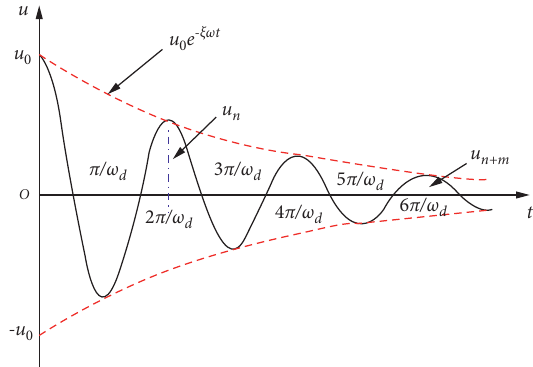
Figure 3: Time-history curve of free vibration for a typical low-damping system.